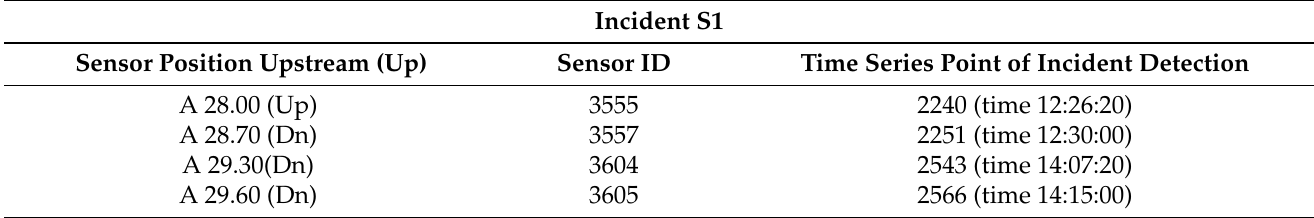
Table 2. Incident S1 (position: A 28.5, true time point index: 2268, true time 12:35:40): The detection results obtained by each sensor using the previous phase space reconstruction–based method [39].